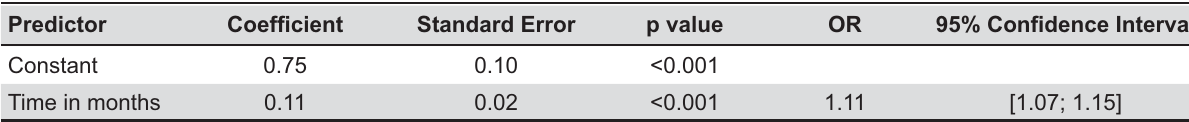
Table 3- (cid:2)(cid:3)(cid:4)(cid:5)(cid:6)(cid:7)(cid:8)(cid:2)(cid:9)(cid:10)(cid:11)(cid:4)(cid:12)(cid:13)(cid:4)(cid:14)(cid:2)(cid:7)(cid:15)(cid:11)(cid:7)(cid:15)(cid:12)(cid:12)(cid:4)(cid:10)(cid:5)(cid:2)(cid:16)(cid:10)(cid:7)(cid:2)(cid:6)(cid:5)(cid:6)(cid:9)(cid:8)(cid:17)(cid:4)(cid:5)(cid:11)(cid:2)(cid:13)(cid:18)(cid:15)(cid:2)(cid:4)(cid:5)(cid:19)(cid:20)(cid:15)(cid:5)(cid:14)(cid:15)(cid:2)(cid:10)(cid:16)(cid:2)(cid:21)(cid:7)(cid:15)(cid:6)(cid:12)(cid:13)(cid:16)(cid:15)(cid:15)(cid:22)(cid:4)(cid:5)(cid:11)(cid:2)(cid:22)(cid:20)(cid:7)(cid:6)(cid:13)(cid:4)(cid:10)(cid:5)(cid:2)(cid:10)(cid:5)(cid:2)(cid:13)(cid:18)(cid:15)(cid:2)(cid:23)(cid:7)(cid:15)(cid:24)(cid:6)(cid:9)(cid:15)(cid:5)(cid:14)(cid:15)(cid:2)(cid:10)(cid:16)(cid:2)(cid:6)(cid:5)(cid:13)(cid:15)(cid:7)(cid:4)(cid:10)(cid:7)(cid:2)(cid:10)(cid:23)(cid:15)(cid:5)(cid:2) bite in the total sample (n=1,377)